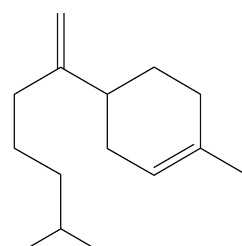
Figure 3: Structure of α -bisabolene.